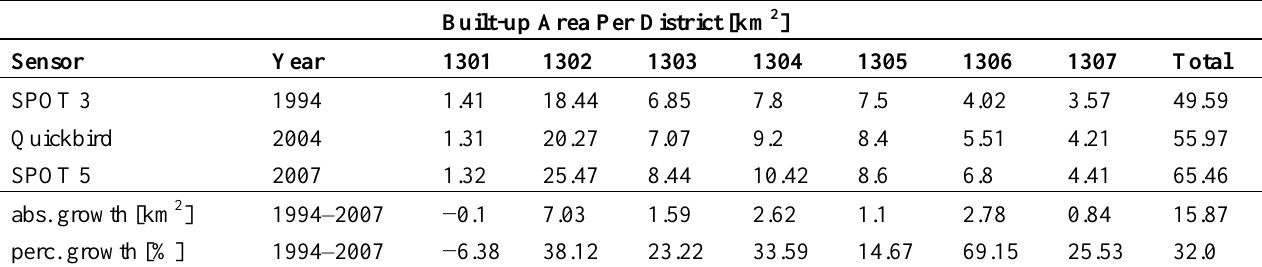
Table 4. Sana’a urban expansion statistics (1994–2007).